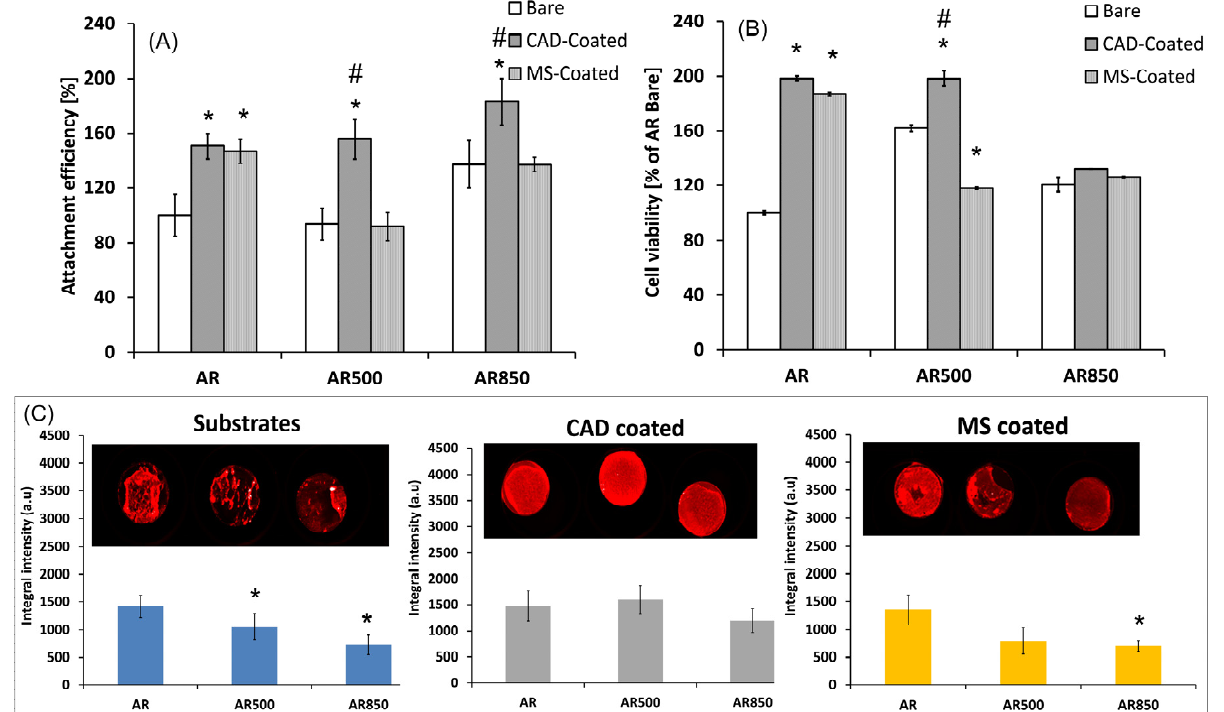
Figure 11. Cell adhesion after 6-h residence time. ( A ), cell viability for 24 h ( B ) and bone mineralization activity of MG63 osteoblasts after 31 days of incubation ( C ) with uncoated and TiN/TiO 2 coated, polished and EBM samples of Ti64 in as-received (AR) state. Three independent studies of the cell culture samples were performed. Results are averaged and the standard deviation is indicated. * p < 0.05 compared to the polished uncoated AR sample; # p < 0.05 compared to the MS coated sample in the respective series.